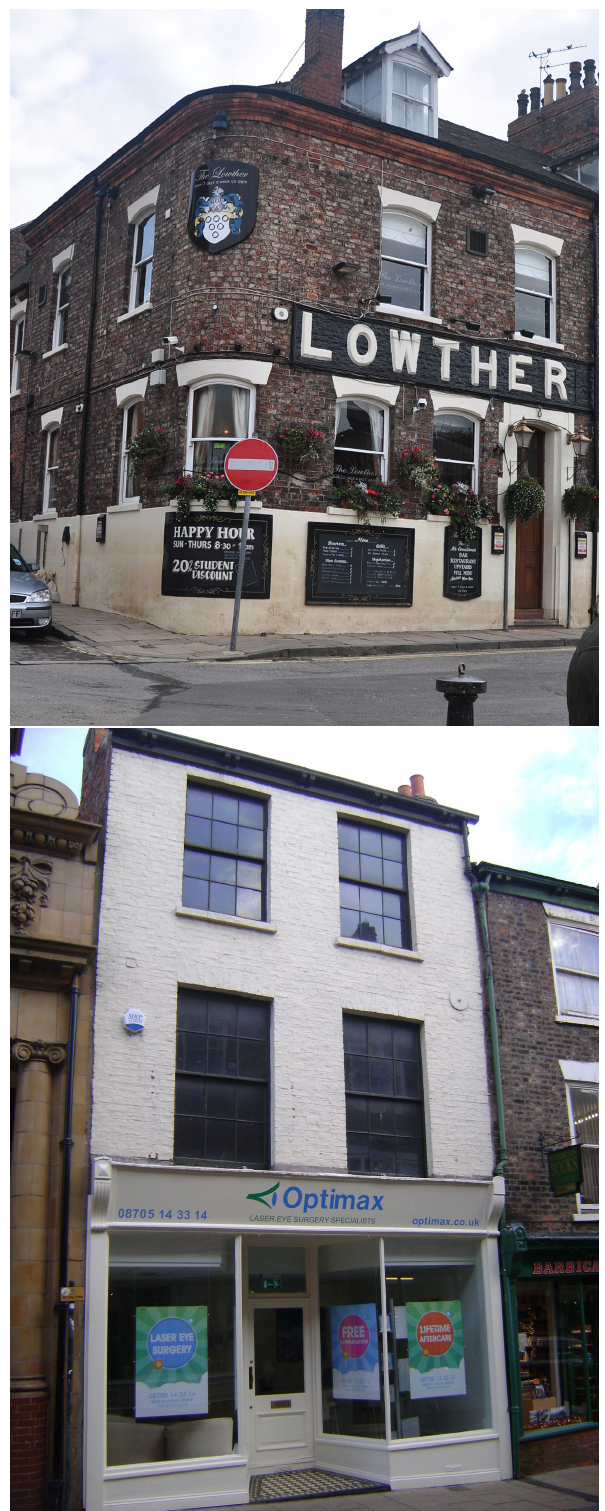
Fig. 8. (a) Riverfront, York, (b) Fishergate, York.